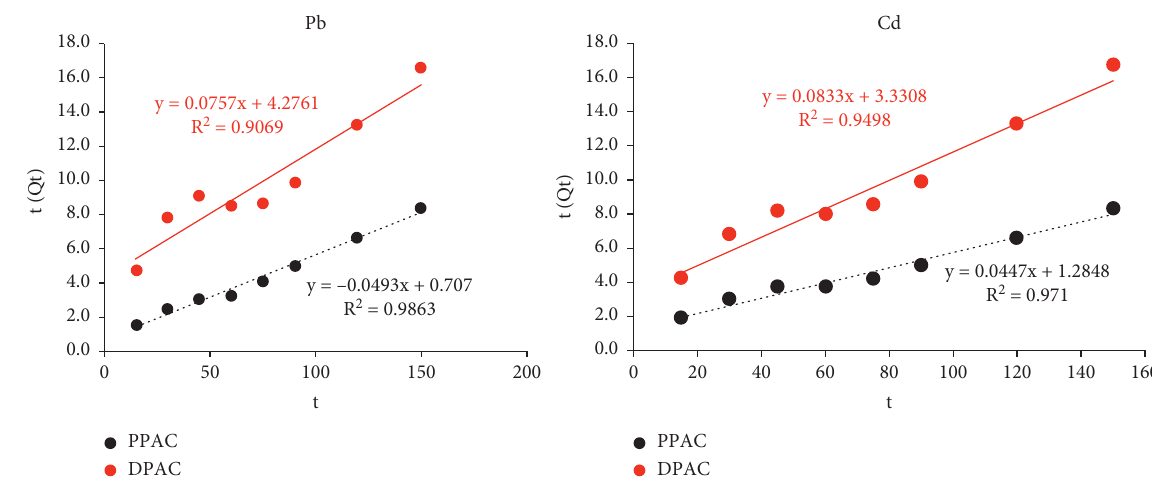
Figure 13: Pseudo-second-order reaction plots for Pb(II) and Cd(II) adsorption onto DPAC and